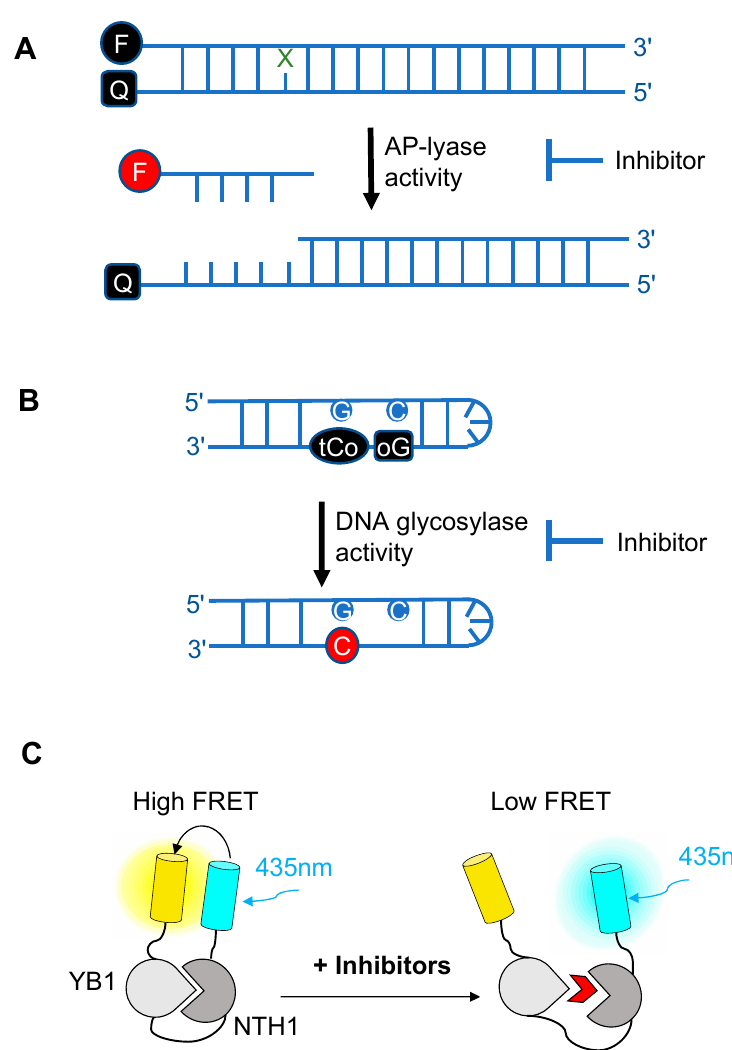
Figure 3. Schematic diagrams illustrating the different fluorescence-based assays developed over the past decade for high-throughput screening (HTS) of chemical libraries for the selection of inhibitors of either the AP-lyase activity [193] ( A ), the DNA glycosylase activity [197] ( B ) of DNA glycosylases, or of the interaction interface ( C ) between a DNA glycosylase (here, NTH1) and its cellular partner (YB1) [162]. FRET: Förster resonance energy transfer. In ( A ), X denotes a damaged base processed by DNA glycosylases. Cleavage by the AP lyase activity results in the release of the fluorophore-labeled lesion-containing strand and fluorescence emission (red F). In ( B ), release of a modified 8-oxo-G base (oG) linked to a quencher that specifically quenches the highly fluorescent DNA base analogue, tCo, covalently bound to the neighboring base, leads to fluorescence emission (red C). In ( C ), NTH1-YB1 complex formation is associated with high FRET levels, which are significantly reduced by inhibitors (red wedge) of the PPI interface.